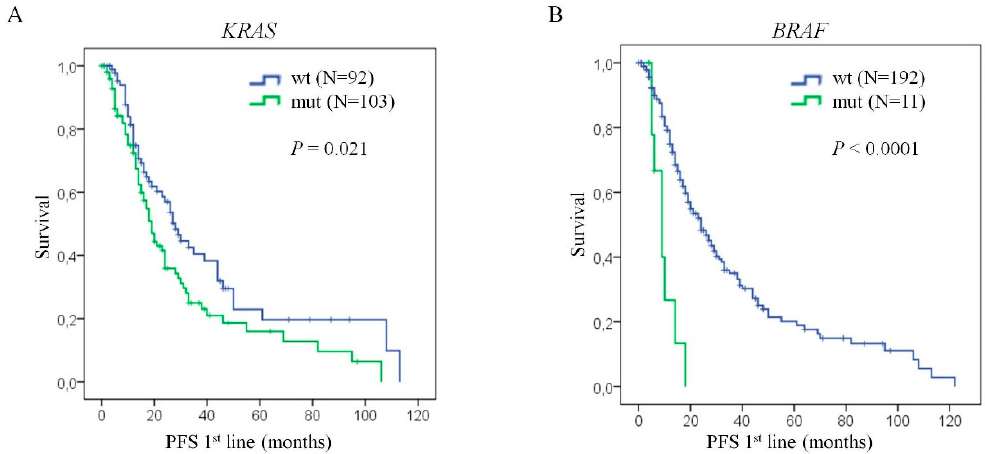
Figure 2. KRAS or BRAF mutations confer poor prognosis to mCRC patients. Kaplan Meier curves of progression-free survival of mCRC patients, ( A ) with KRAS mutations versus KRAS wild-type, and ( B ) with BRAF V600E mutations versus BRAF wild-type. Statistical analysis performed with log-rank test. N: number of patients; PFS: progression-free survival; wt: wild-type; mut: mutated; P : p- Value .